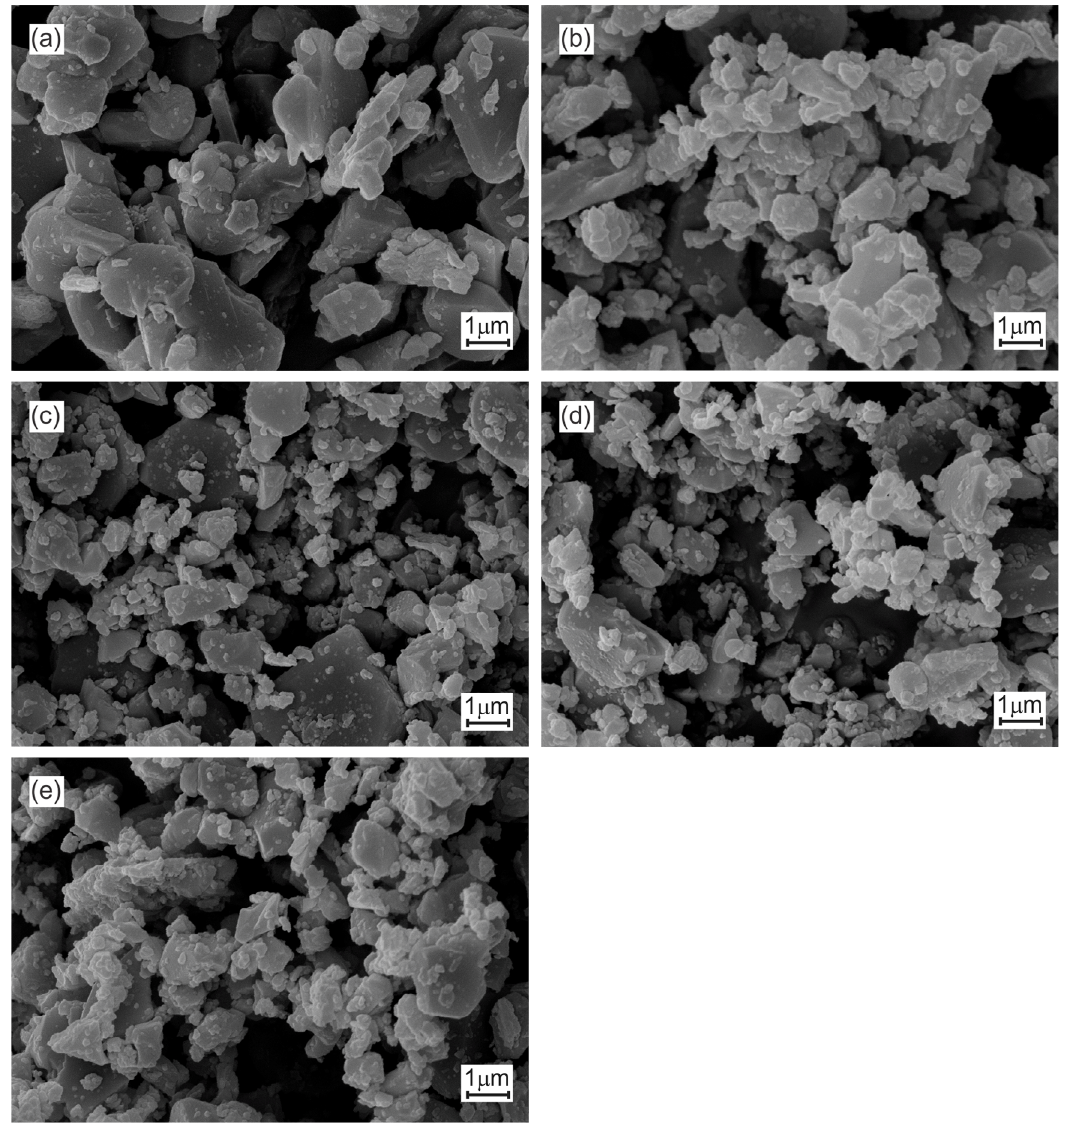
Figure 4. Scanning electron microscope images. (a) Raw material (alumina APC-G). (b) Ball (Ø=3 mm). (c) Ball (Ø=5 mm). (d) Ball (Ø=3 and 5 mm). (b) Cylinder (Ø=5 mm x 5 mm).